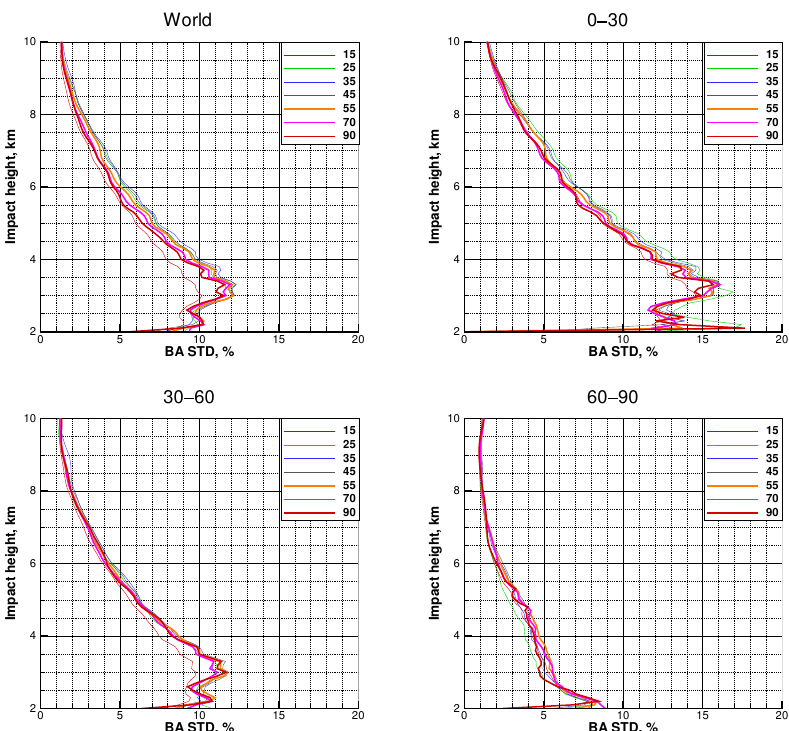
Figure 12. Similar to Figure 3. METOP-B, standard deviation, dynamic normalization.